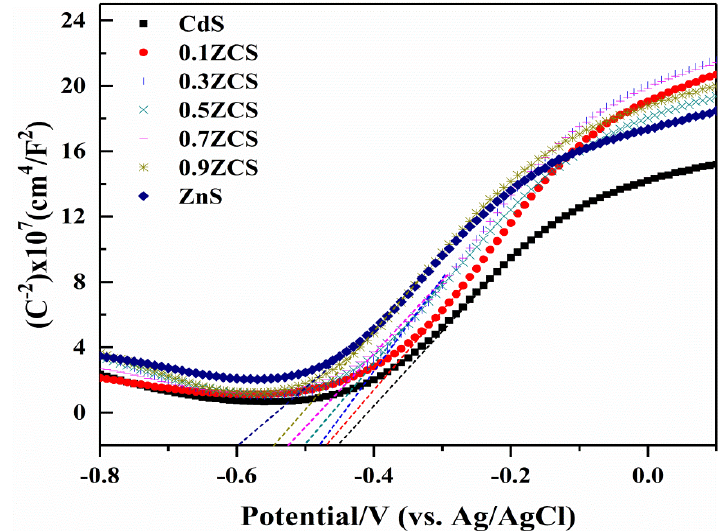
Figure 4. The UV ‐ Vis DRS spectra of the Zn x Cd 1 − x S (x = 0–1.0) samples. Figure 4. The UV-Vis DRS spectra of the Zn x Cd 1 − x S (x